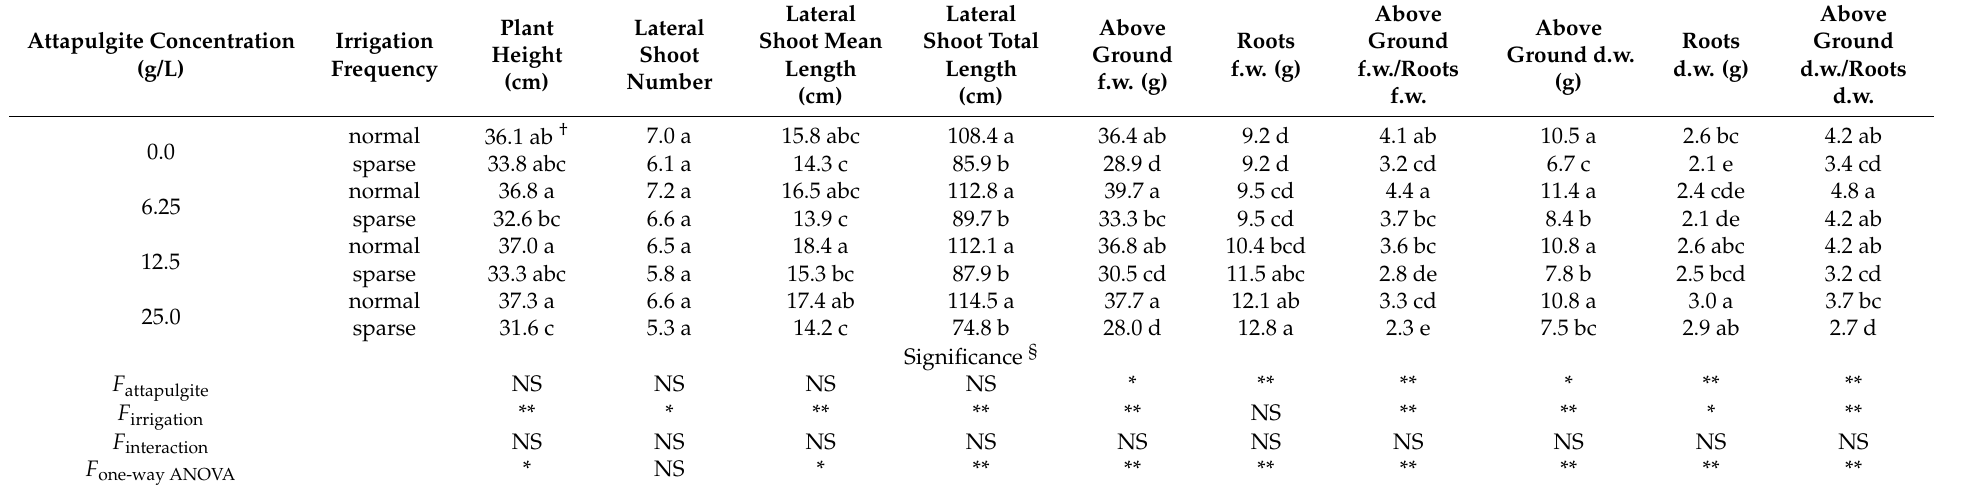
Table 6. Effect of attapulgite concentration (g/L) and irrigation frequency on growth of Salvia fruticosa , after three months of greenhouse culture on peat: perlite 2:1 ( v / v ).